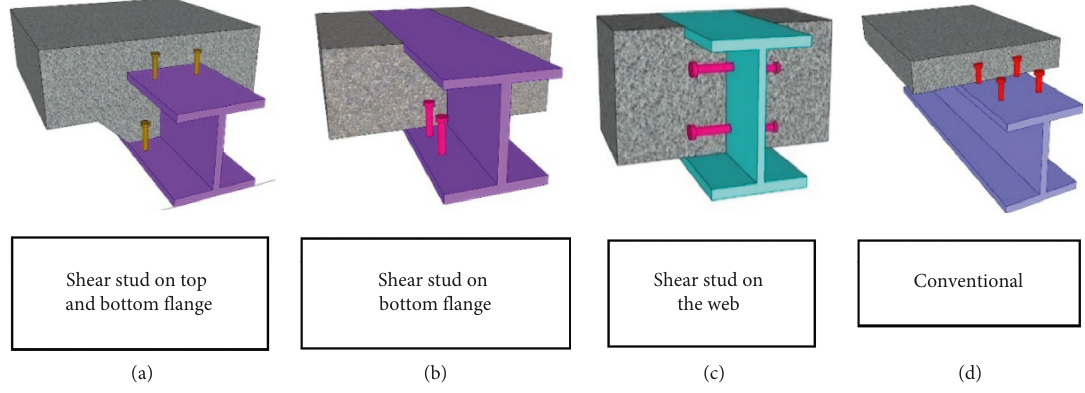
Figure 8: Headed stud welded on flanges of the steel beam in the composite